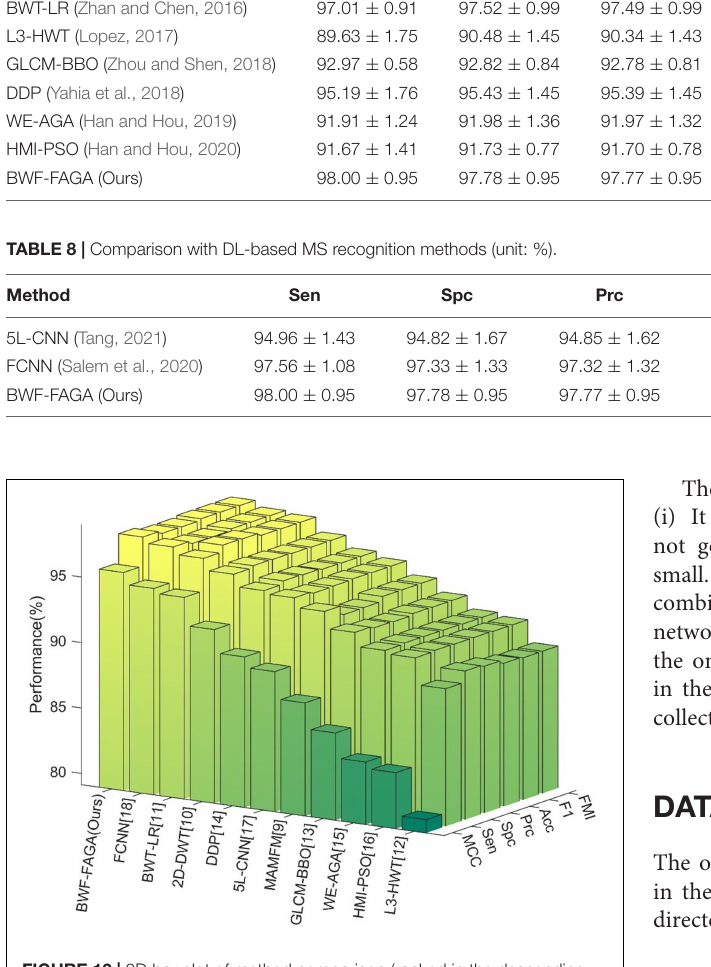
FIGURE 13 | 3D bar plot of method comparison (ranked in the descending order of